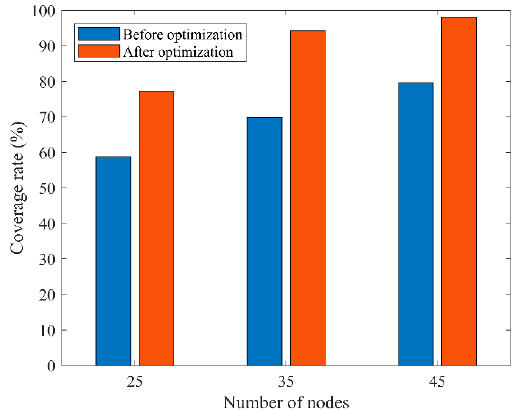
Figure 16. Comparison of coverage rates before and after optimization by COOTCLCO under different numbers of nodes.